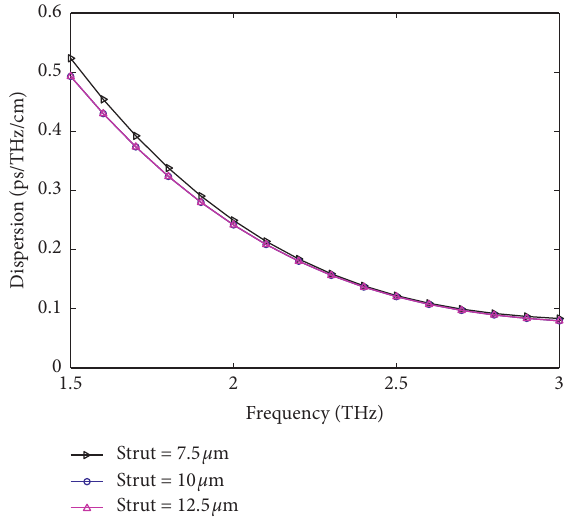
Figure 12: Representation of the dispersion in the THz band for the three strut